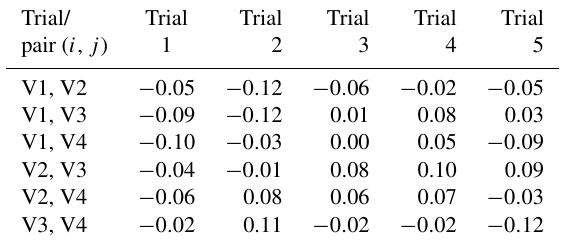
Table 3. Mean values of the imaginary part of the complex correla- tion coefficient over frequency for different antenna